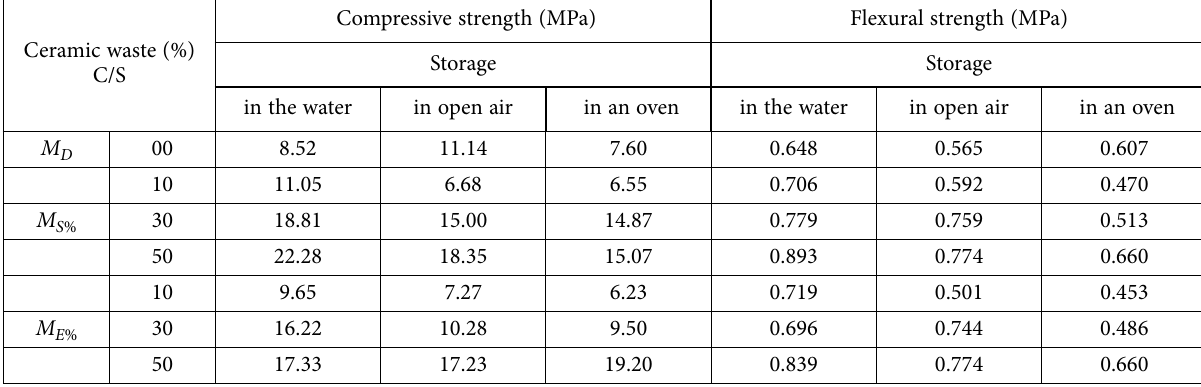
Table 2. Properties of mechanical mortars made in laboratory and have undergone different cures